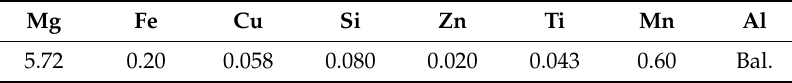
Table 1. Chemical compositions of the studied 5A70 aluminum alloy (wt.%). Mg Fe Cu Si Zn Ti